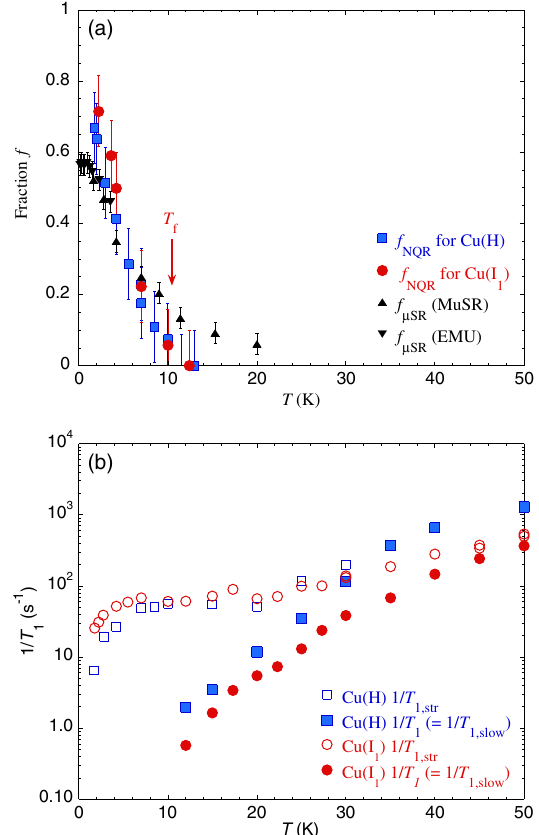
FIG. 5. (a) The lost fraction f of the 63 Cu NQR signal NQR intensity measured at the 63 Cu ð I 1 Þ and 63 Cu ð H Þ sites at a fixed delay time τ ¼ 10 μ s. Also plotted are the fraction f μ of the fast SR depolarizing component of the μ SR signals, as measured by zero field μ SR techniques using the MuSR (triangles) and EMU (downward triangles) spectrometers at the Rutherford Appleton Laboratory [25]. (b) A precursor of the spin freezing observed above T f in the spin-lattice relaxation rate 1 =T 1 . Intrinsic 1 =T 1 , obtained as the slower component 1 =T 1 ; from the two- slow component fit with Eq. (A3) below ∼ 60 K (i.e., 1 =T 1 ¼ ∼ 60 K), continues to slow down at low temper- 1 =T 1 ; slow below atures. In contrast, the sample averaged behavior represented by 1 =T M ð t Þ with Eq. (A2), 1 ; str , estimated from the stretched fit of levels off below ∼ 30 K. See Appendix A for details of the